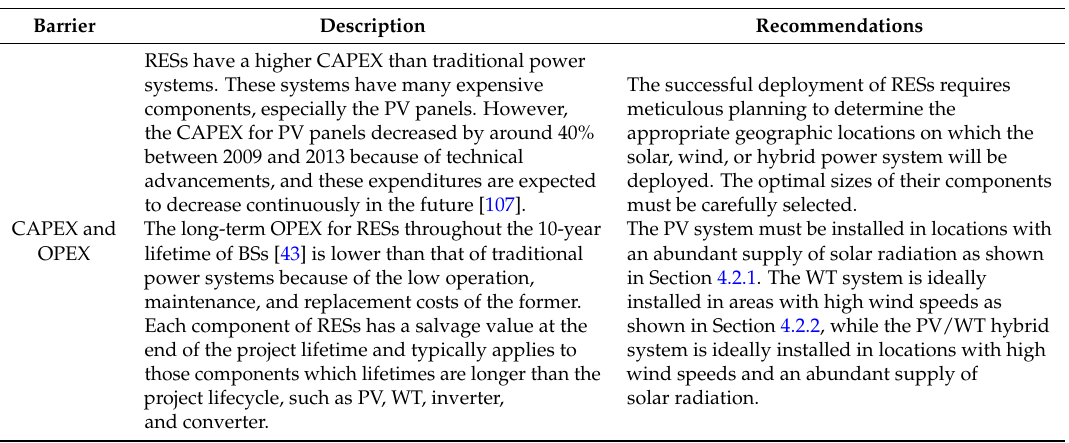
Table 5. Barriers that hinder the spread of green BSs and potential solutions.